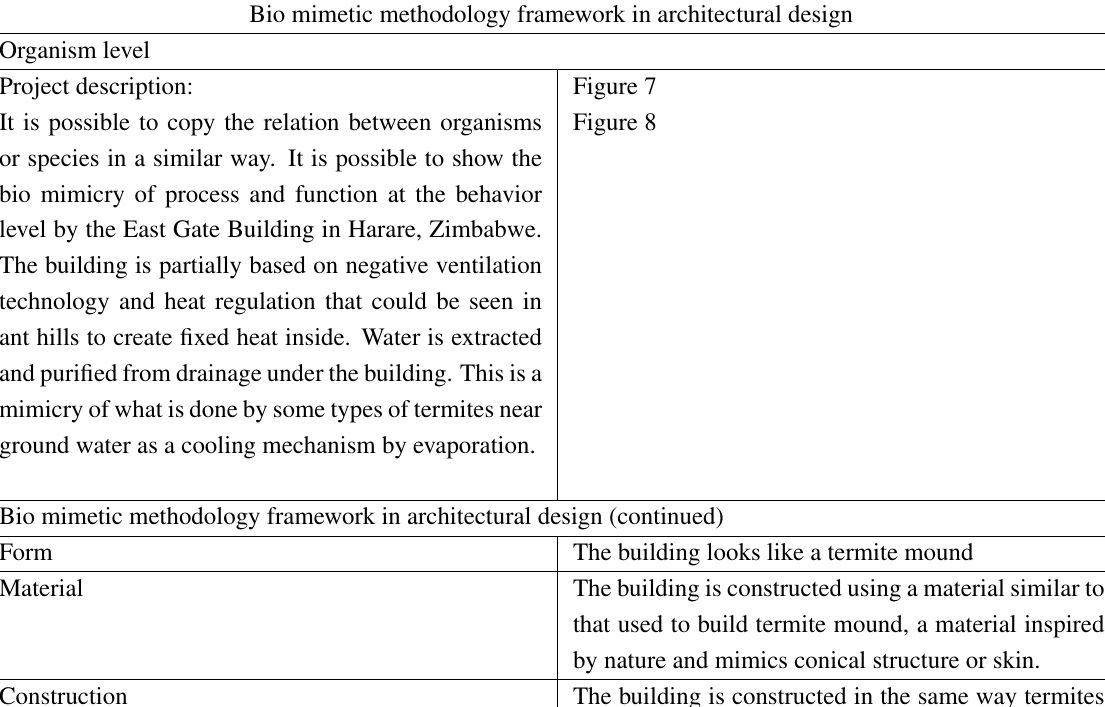
Table 2. Bio mimetic of architectural form at organism level Source: collated by the